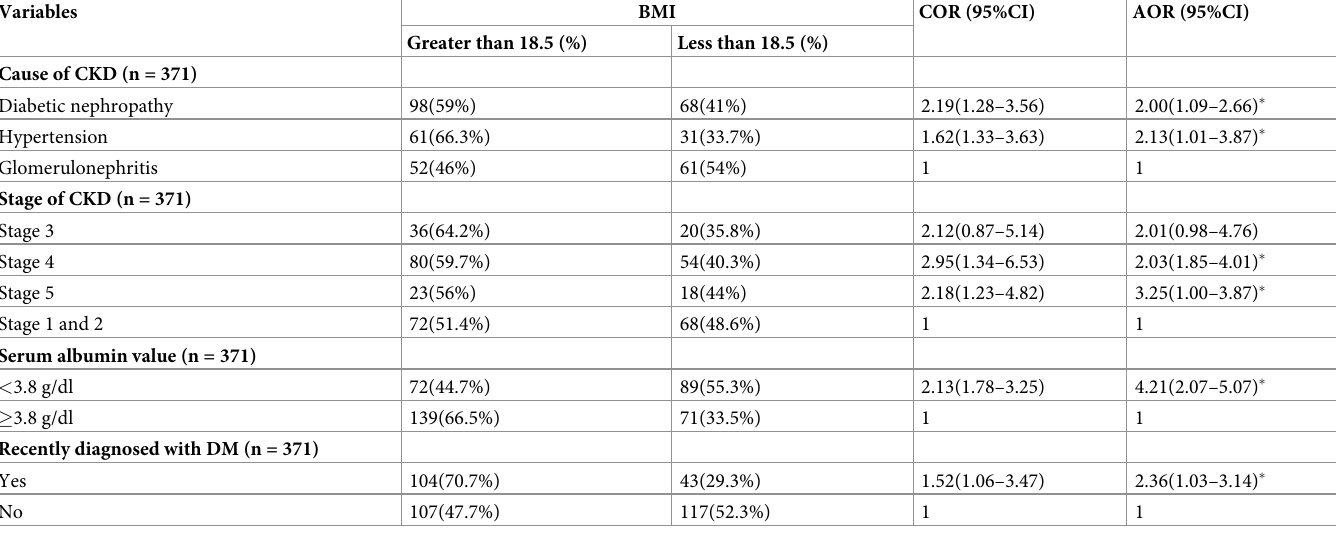
Table 5. Factors associated with undernutrition among CKD patients in Saint Paulo’s and Zewditu Memorial Hospitals in Addis Ababa, Ethiopia,